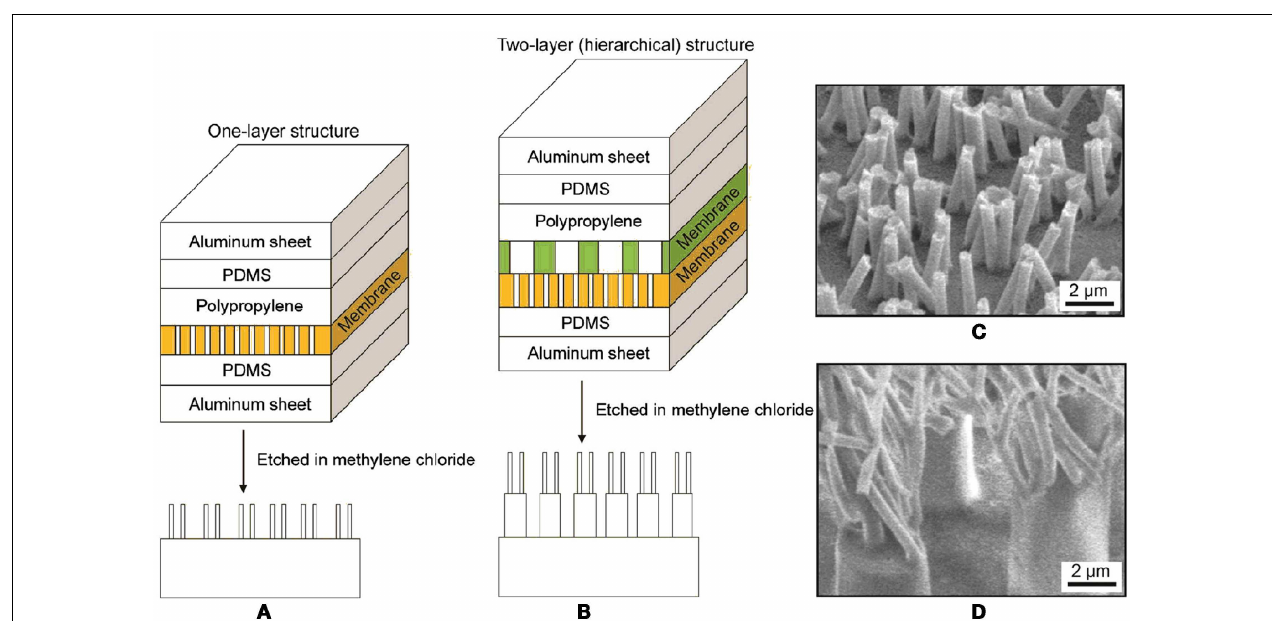
are etched using methylene chloride to obtain the nanostructured samples. (C) SEM image of 600nm one-layer structure, and (D) two-layer structure made from polypropylene. Lee and Bushan (2012).